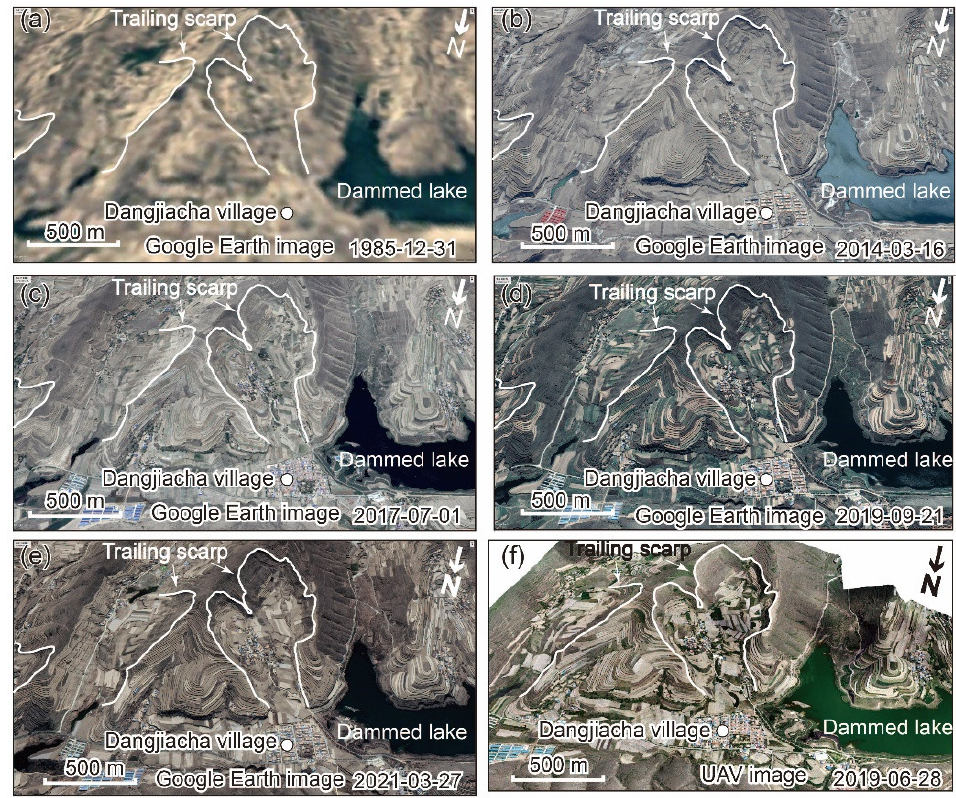
Figure 4. Multi-temporal Google Earth images and UAV survey images. ( a – e ) Different temporal Google Earth images in the same view; ( f ) UAV images obtained from field investigation.